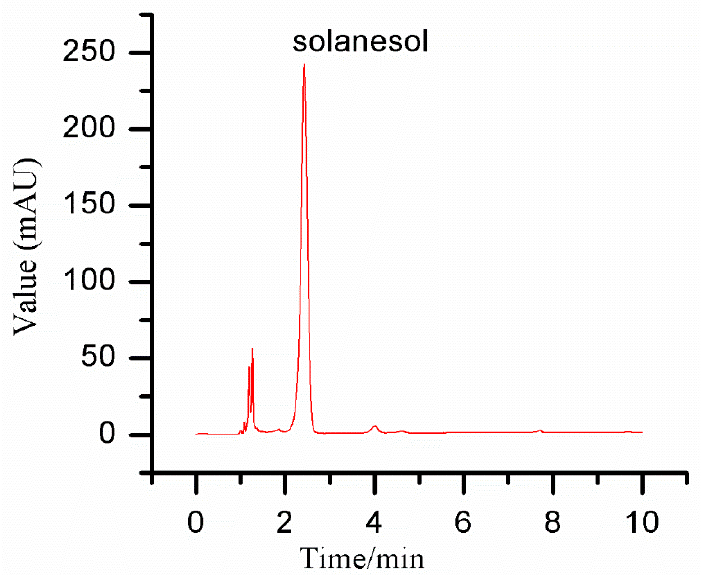
Figure 1. Liquid chromatogram of solanesol in methanol solution.